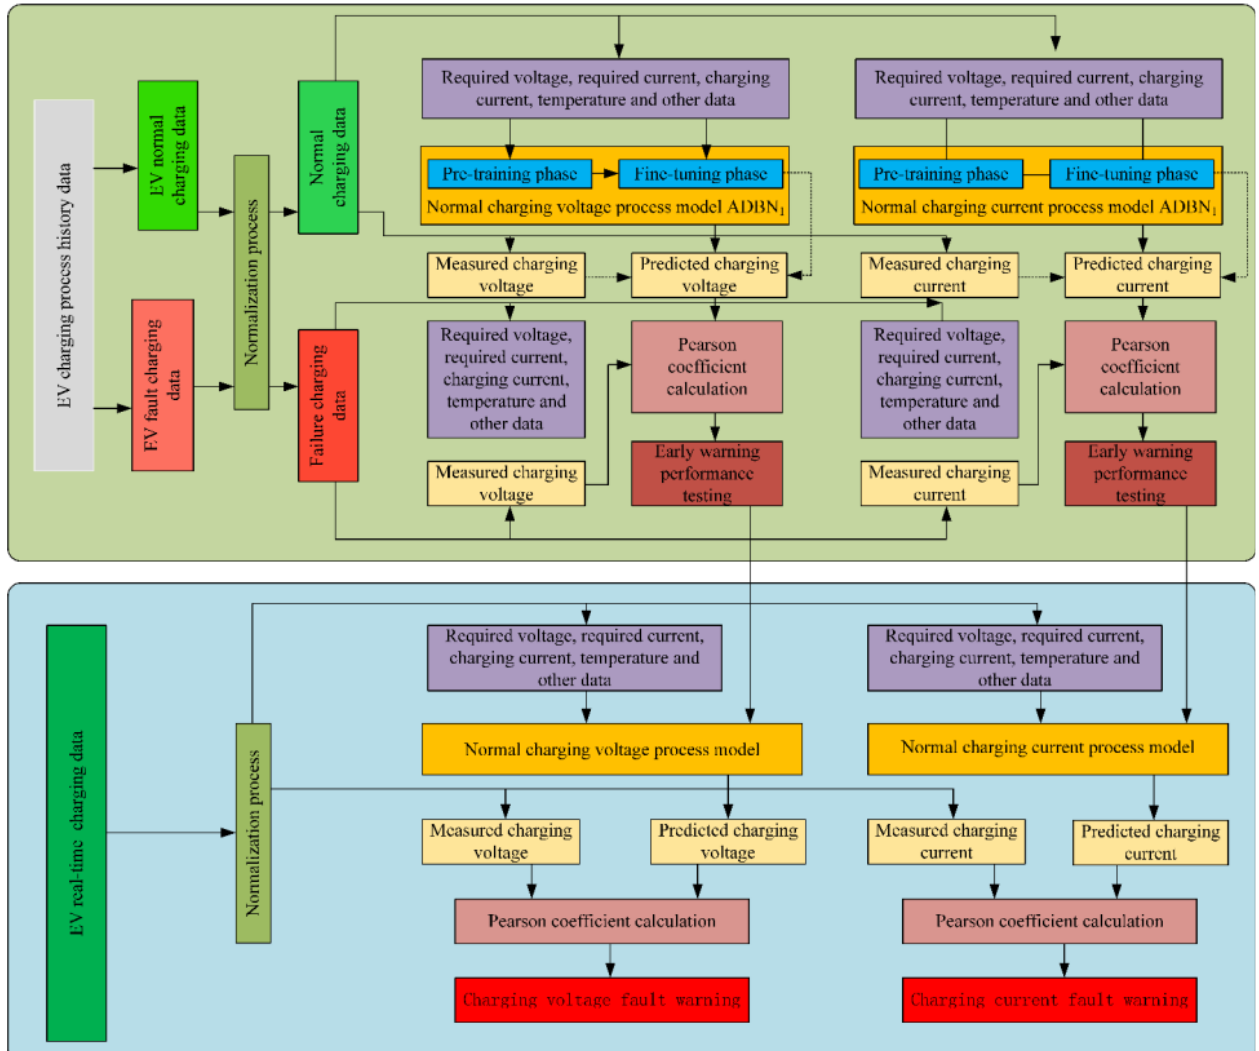
Figure 3. EV charging fault warning